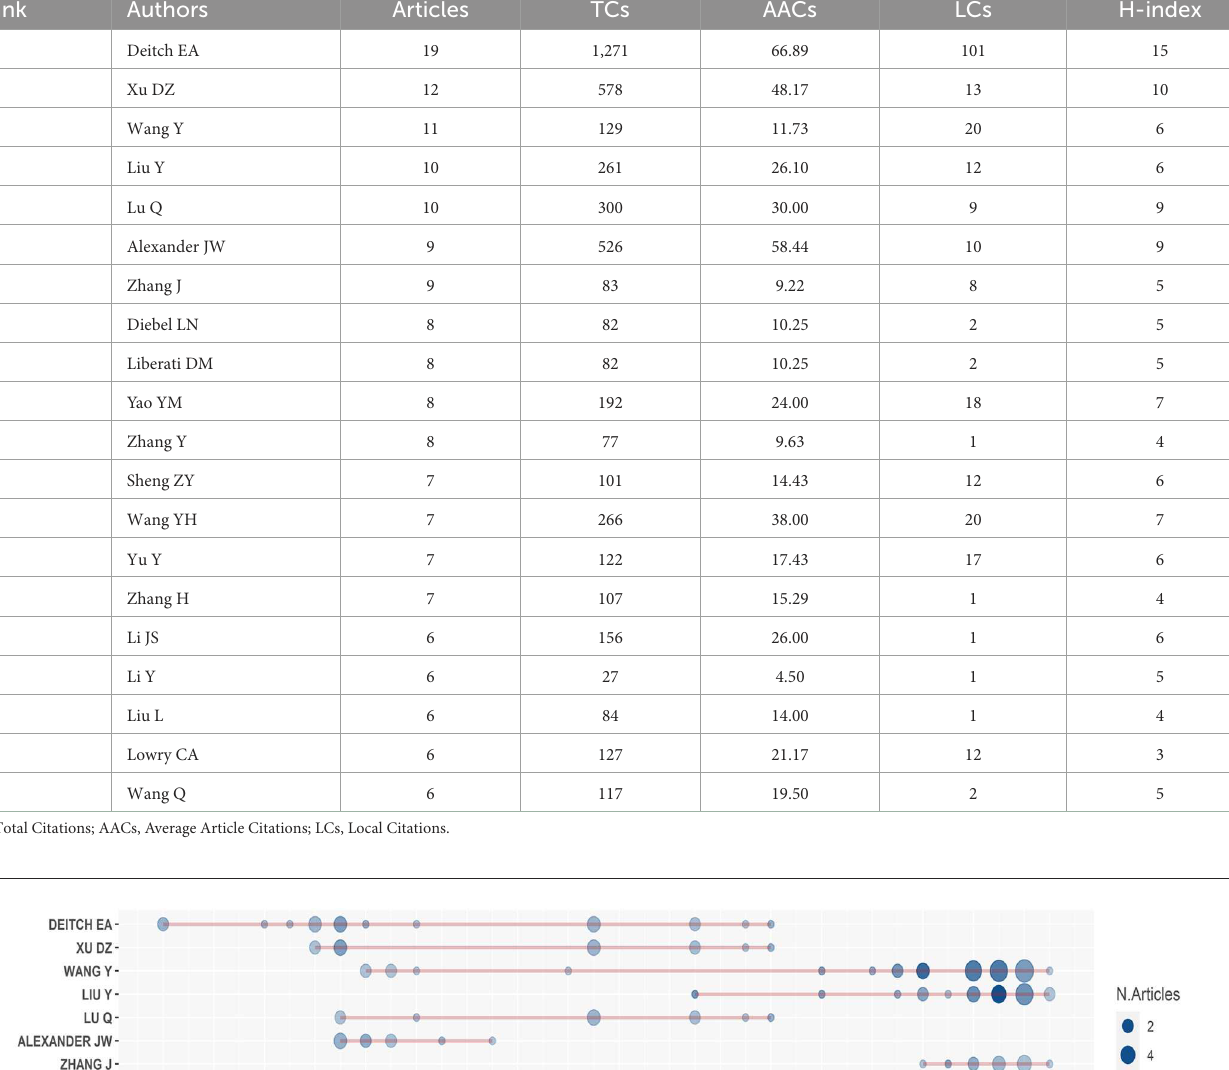
top 5 most productive institutions, and top 5 most productive and cited journals were highly consistent with the original results (Supplementary Figures S7A–E). Deitch EA was still the most influential author (Supplementary Figures S7F, G). The